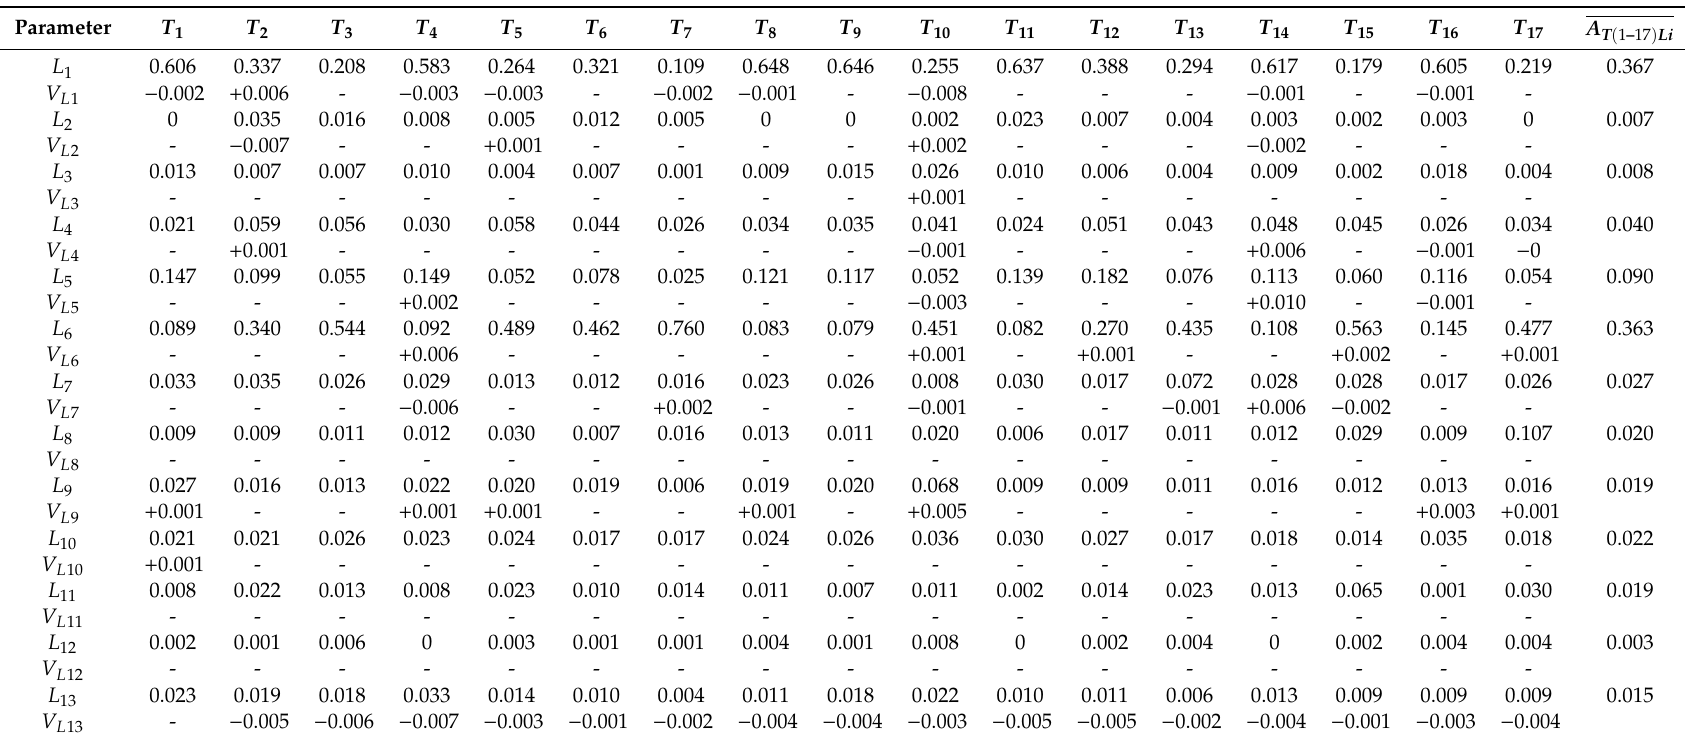
Table A9. Activity per land category in Russia, Central Federal District. Mean values for